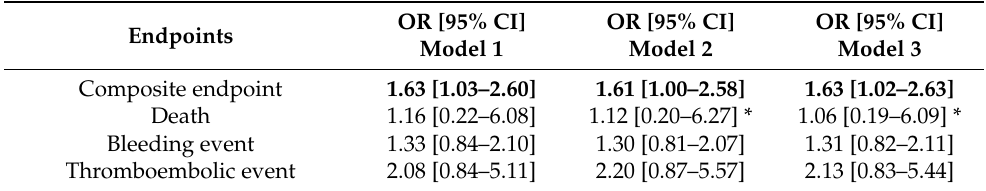
Table 3. Adjusted odds ratios for the individualized risk assessment group compared with the standardized risk assessment group for study endpoints ( N =